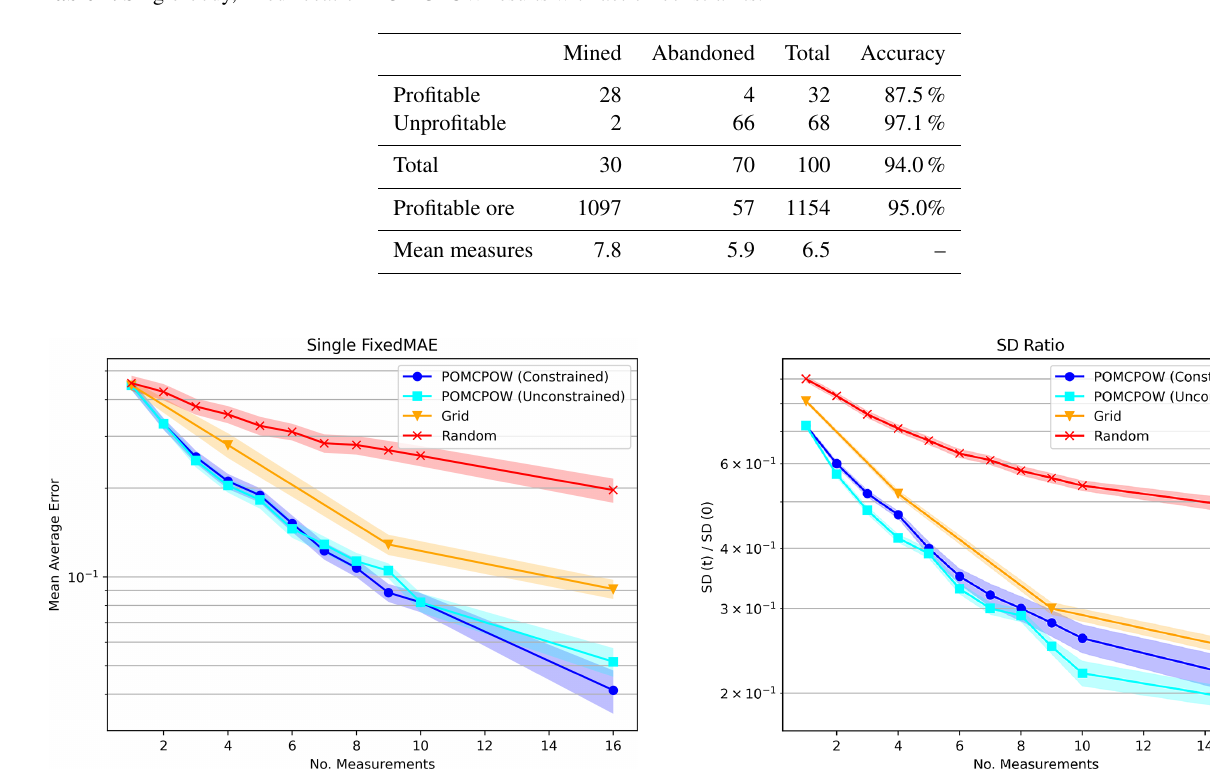
Figure 12. Baseline grid patterns. The panels show the baseline grid patterns for 2-by-2, 3-by-3, and 4-by-4 grids, each with a total of 4, 9, and 16 measurements, respectively. The grids cover the extent of a w -by- w area in the center of the exploration domain. A single measurement at the center of the domain is also shown in the leftmost panel. Table 2. Single-body, fixed-location POMCPOW results with action constraints.